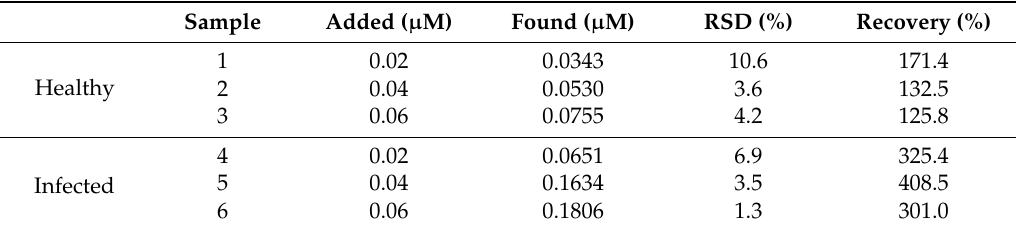
Table 1. Determination of quinoline in oil palm leaf extracts of healthy (Samples 1, 2, 3) and infected (Samples 4, 5, 6) trees. RSD = relative standard